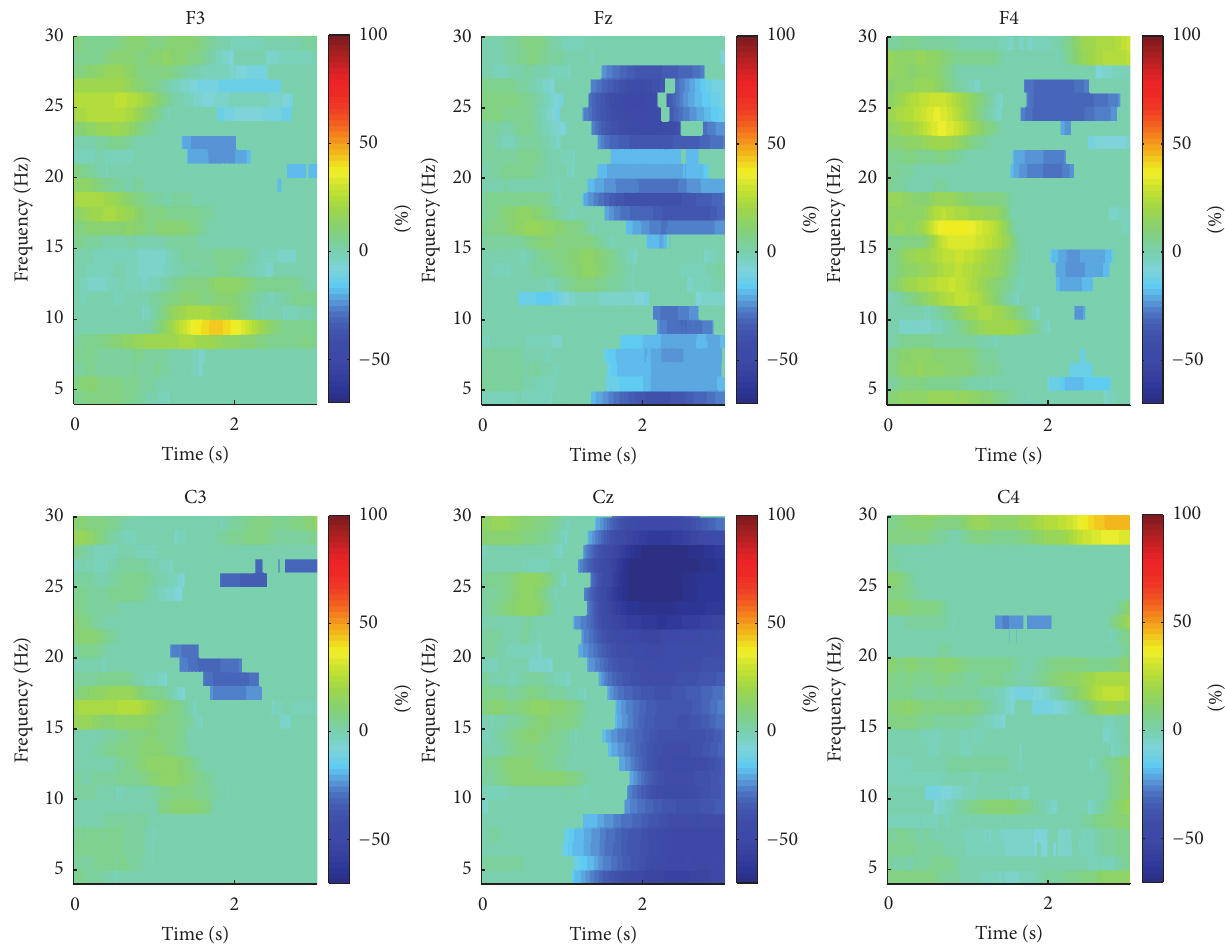
Figure 5: Event related desynchronization maps. We decided to use channel Fz for implementation of the BCI as it displayed behaviour resembling typical ERD (i.e., decreases in the alpha and beta ranges), compared to channel Cz, which showed a decrease of power across the entire spectrum. The plots display significant changes in power as a percentage of a two-second baseline period immediately before the Go cue ( 𝑡 = 0 ). Short increases in power were associated with ocular